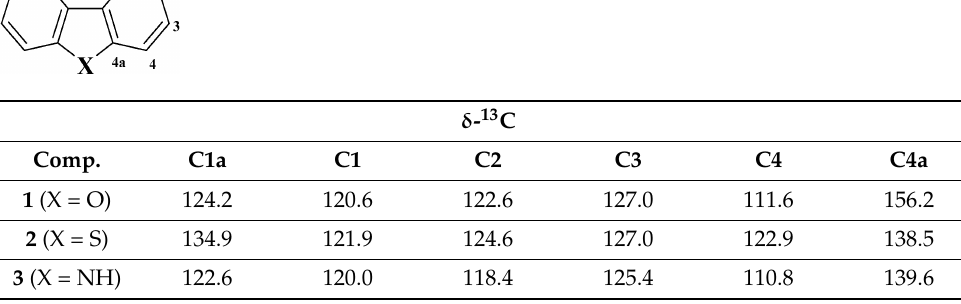
Table 1. Effect of heteroatom X on δ - 13 C in dibenzofused heteroaromatic compounds.